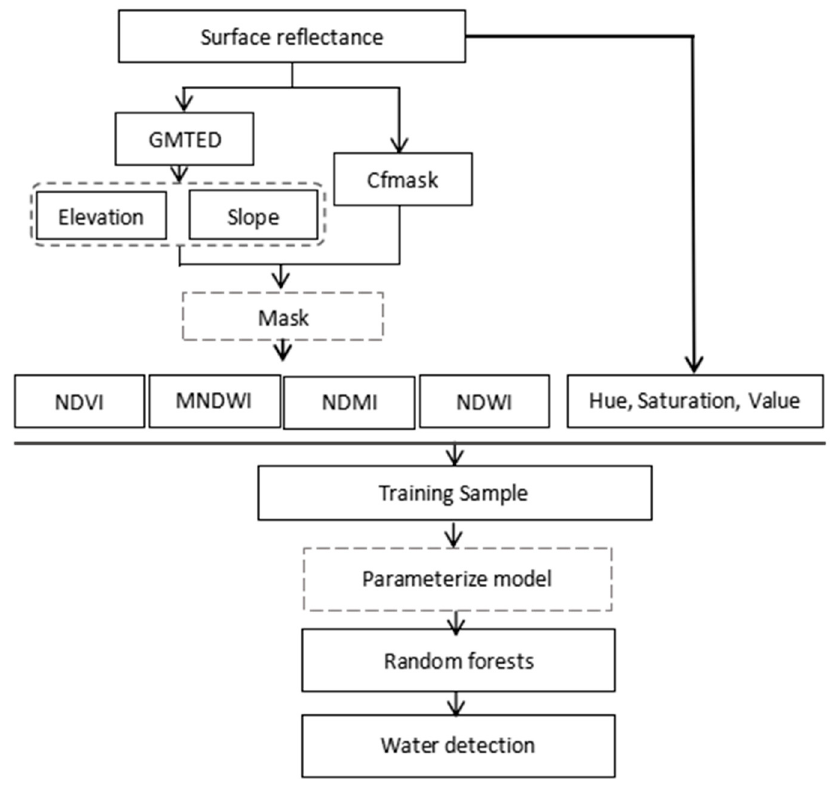
Figure 3. The flow chart of water classification.